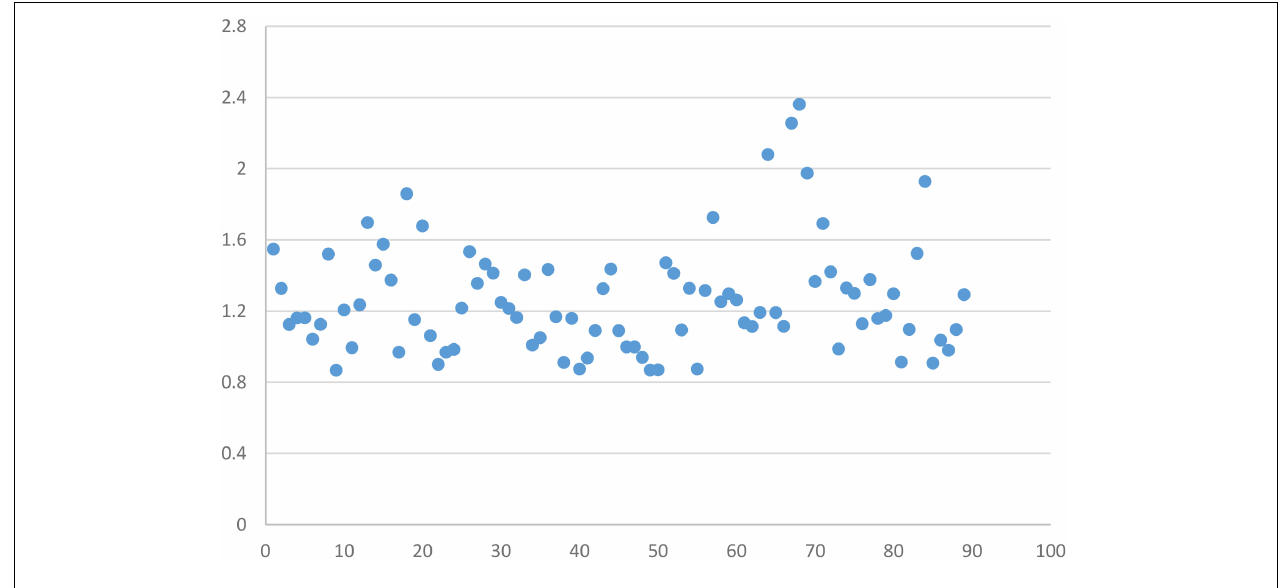
FIGURE 2 | Item discrimination of the item bank.